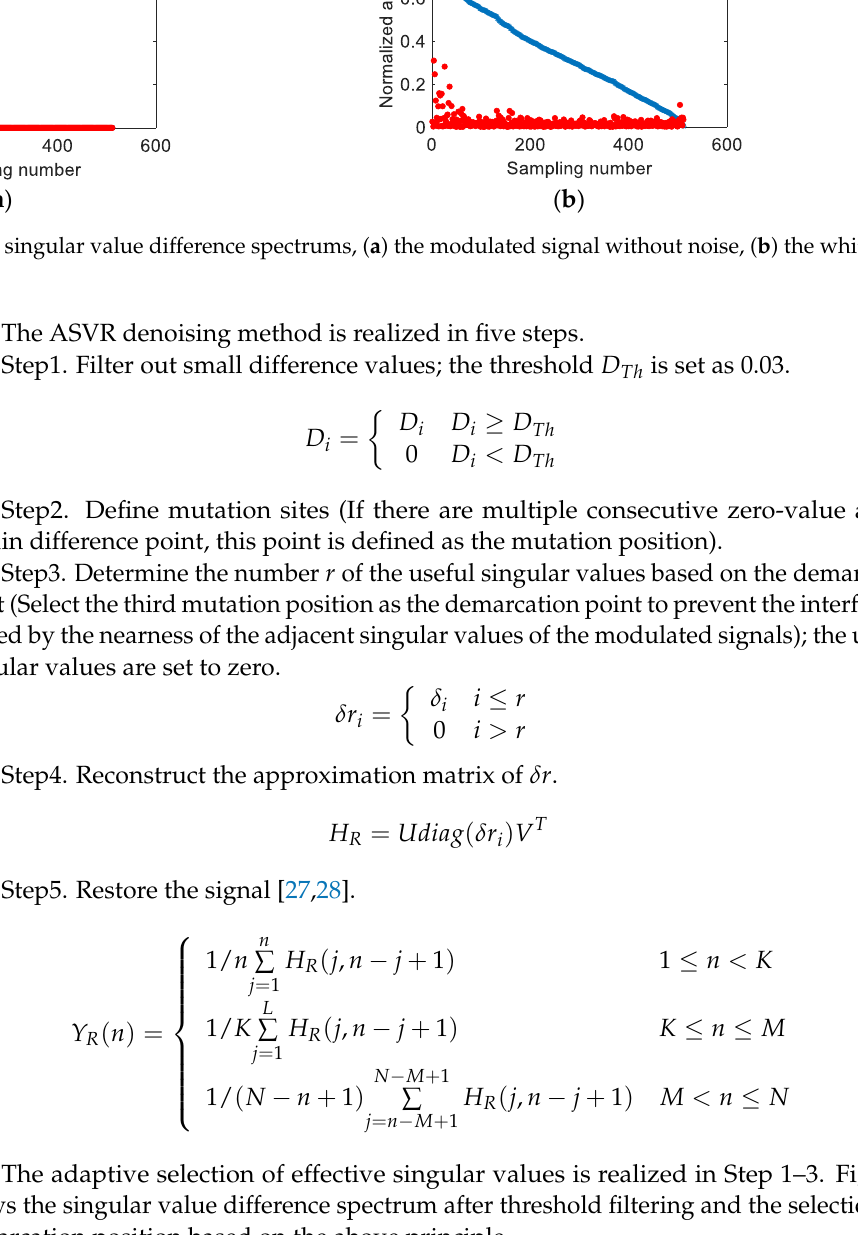
a demarcation position based on the above principle.